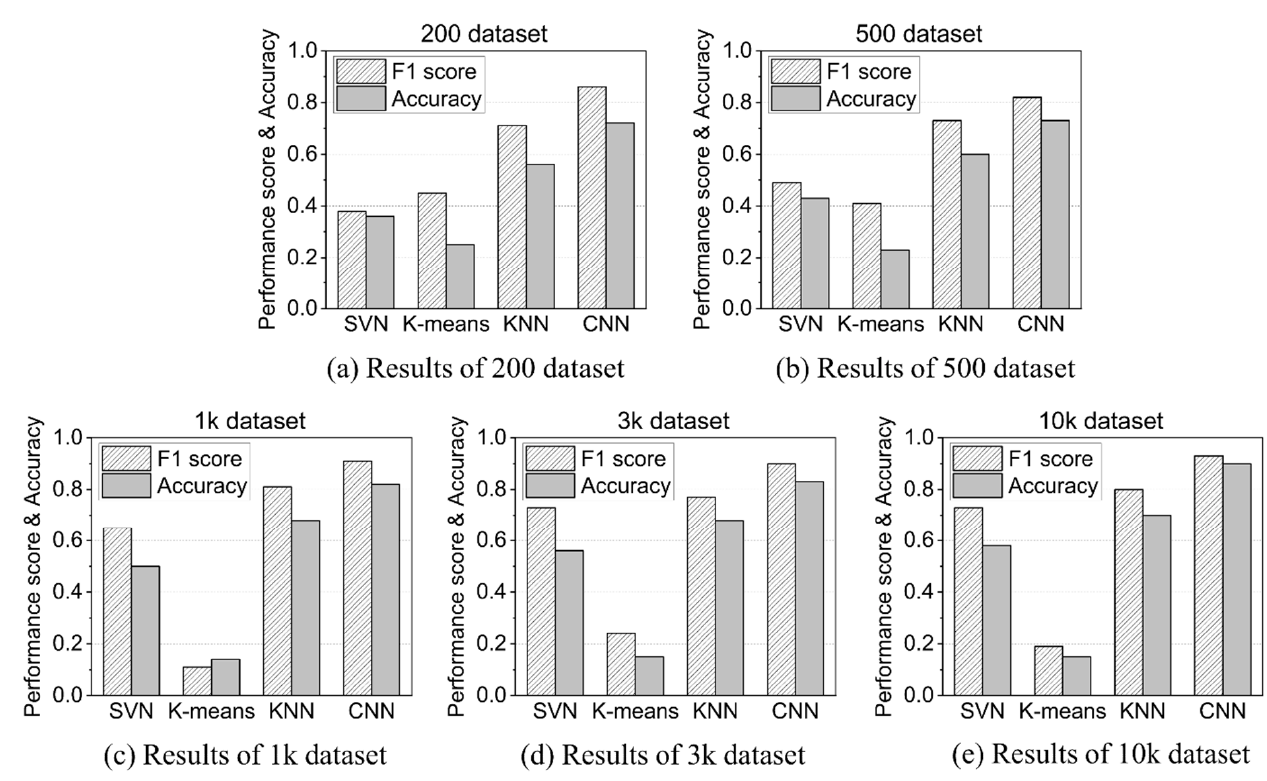
Figure 12. F1 score and accuracy comparison for four models.